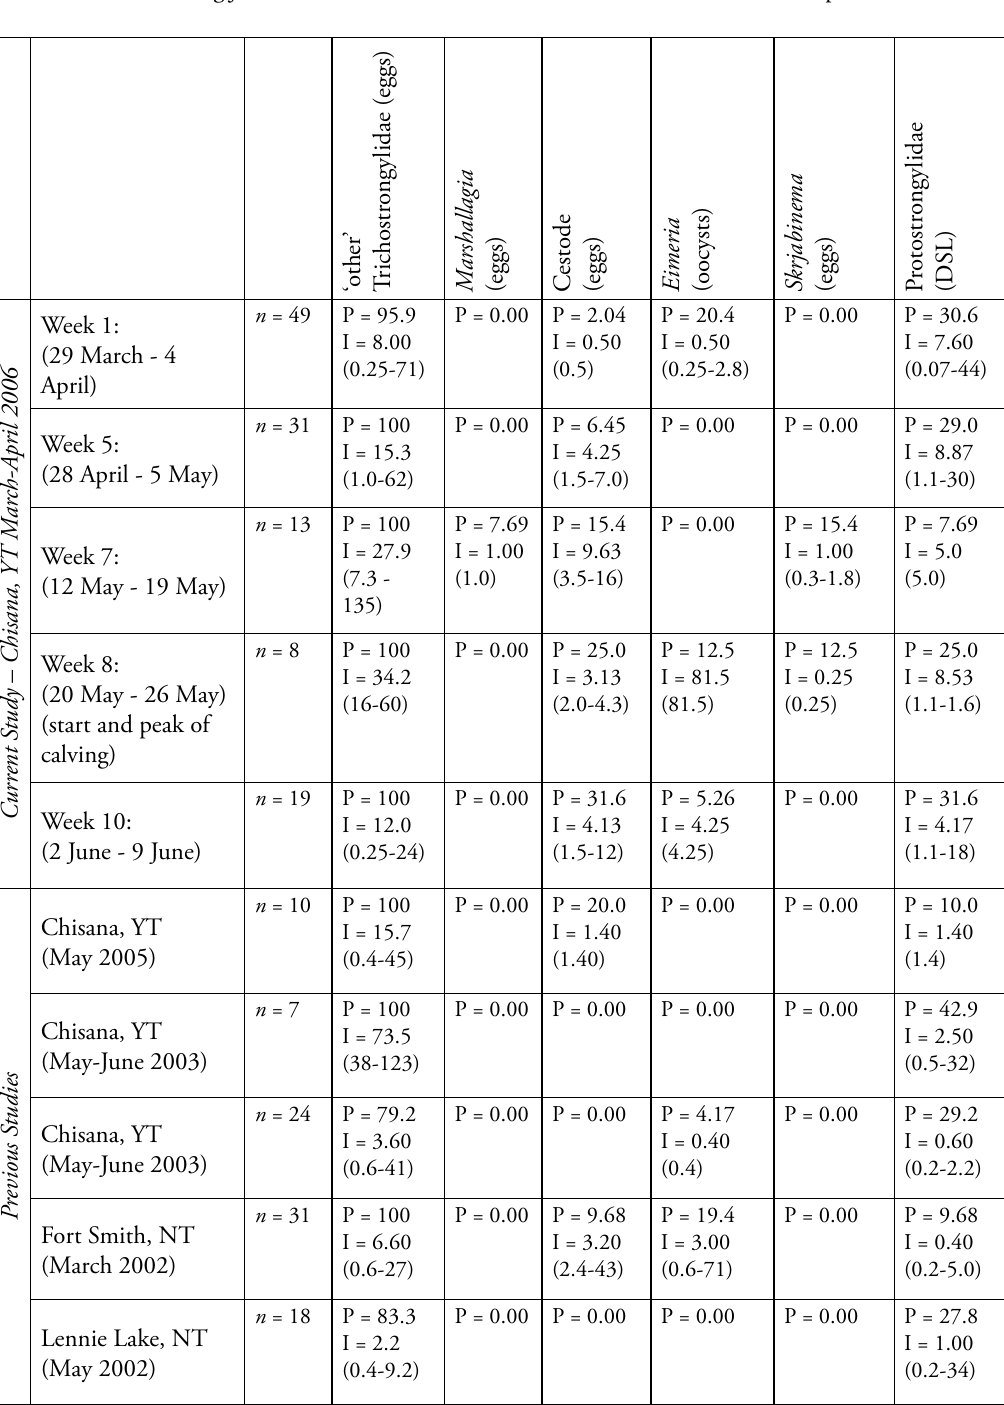
Table 1. Prevalence (P) and median intensity (I) and (range) of parasites per gram of wet feces found in woodland caribou ( Rangifer tarandus caribou ). n = number of adult female caribou